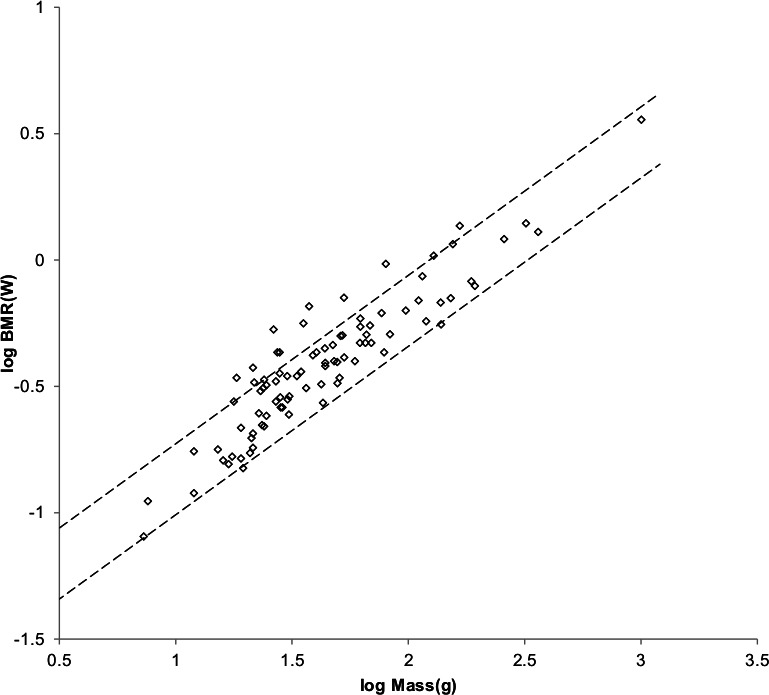
Log BMR as a function of log body mass for Cricetidae.The data are from Kolokotrones et al. (2010). The dashed lines are MMLE sturdiness factor boundaries. The upper boundary was generated with a sturdiness factor s = (3)0.5. The lower boundary was generated with s = (3)−0.5. The boundary lines are for geometric similarity. Cricetid species-averaged BMR, mass data are marked by open diamonds. \documentclass[12pt]{minimal}
\usepackage{amsmath}
\usepackage{wasysym}
\usepackage{amsfonts}
\usepackage{amssymb}
\usepackage{amsbsy}
\usepackage{upgreek}
\usepackage{mathrsfs}
\setlength{\oddsidemargin}{-69pt}
\begin{document}
}{}${R}_{M}^{2}=0.9913$\end{document}RM2=0.9913.